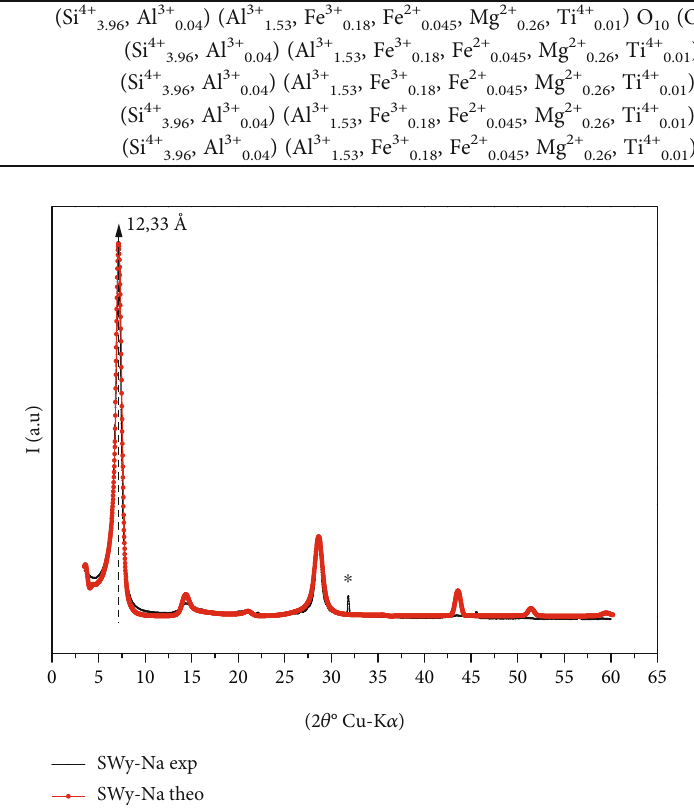
Figure 5: Best agreement between theoretical and experimental XRD pro fi les obtained in the case of SWy-Na. ∗ Halite (NaCl). Table 4: Qualitative XRD investigation in the case of the samples SWy-Na, SWy-Co, SWy-Cu, and SWy-Ba [47, 97]. Sample